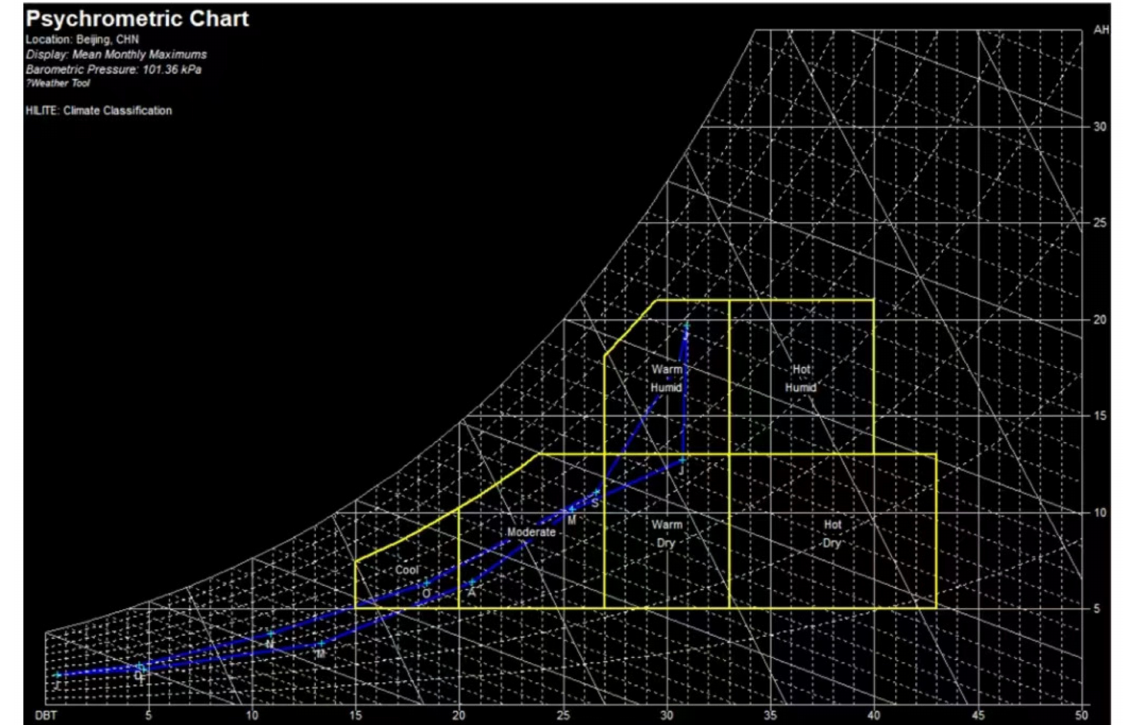
Figure 19. Psychrometric chart analysis.